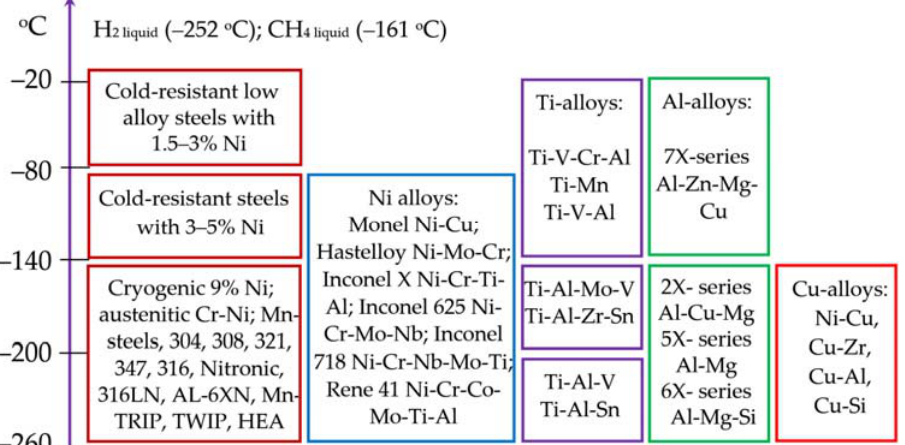
Figure 2. Steels and alloys for low-temperature and cryogenic service.